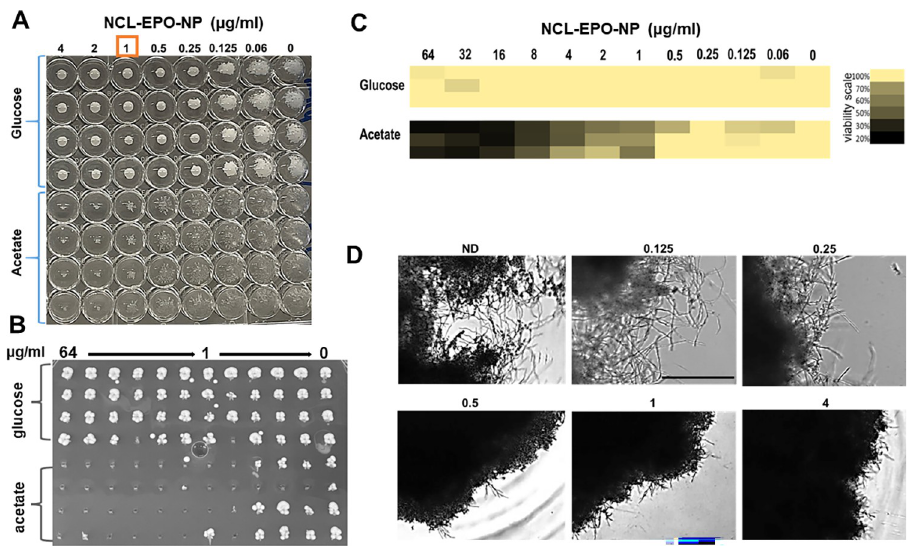
Fig 5. NCL-EPO-NP prevent filamentation and viability of planktonic C . albicans in glucose and acetate, respectively. (A) Dose response assay using round bottom 96-well microtiter plates showed that NCL-EPO-NP could prevent growth of C . albicans in YP+1% acetate (MIC50 of 1 μ g/ml). Also, the NPs appear to prevent filamentation of the fungus at 0.25 μ g/ml in YP+1% glucose. (B) The viability was tested by spotting the NCL-EPO-NP-treated cells on YPD agar. (C) Viability was also monitored using the XTT assay that measures the metabolic activity of cells. (D) Microscopic visualization of reduction in C . albicans filamentation on treatment with different concentrations of NCL-EPO-NP in the presence of 1% glucose. Scale bar = 500 μ m. Raw data are found in the file S1 Data. NCL-EPO-NP, NCL-loaded EPO NP; NP, nanoparticle; YPD, yeast peptone dextrose.